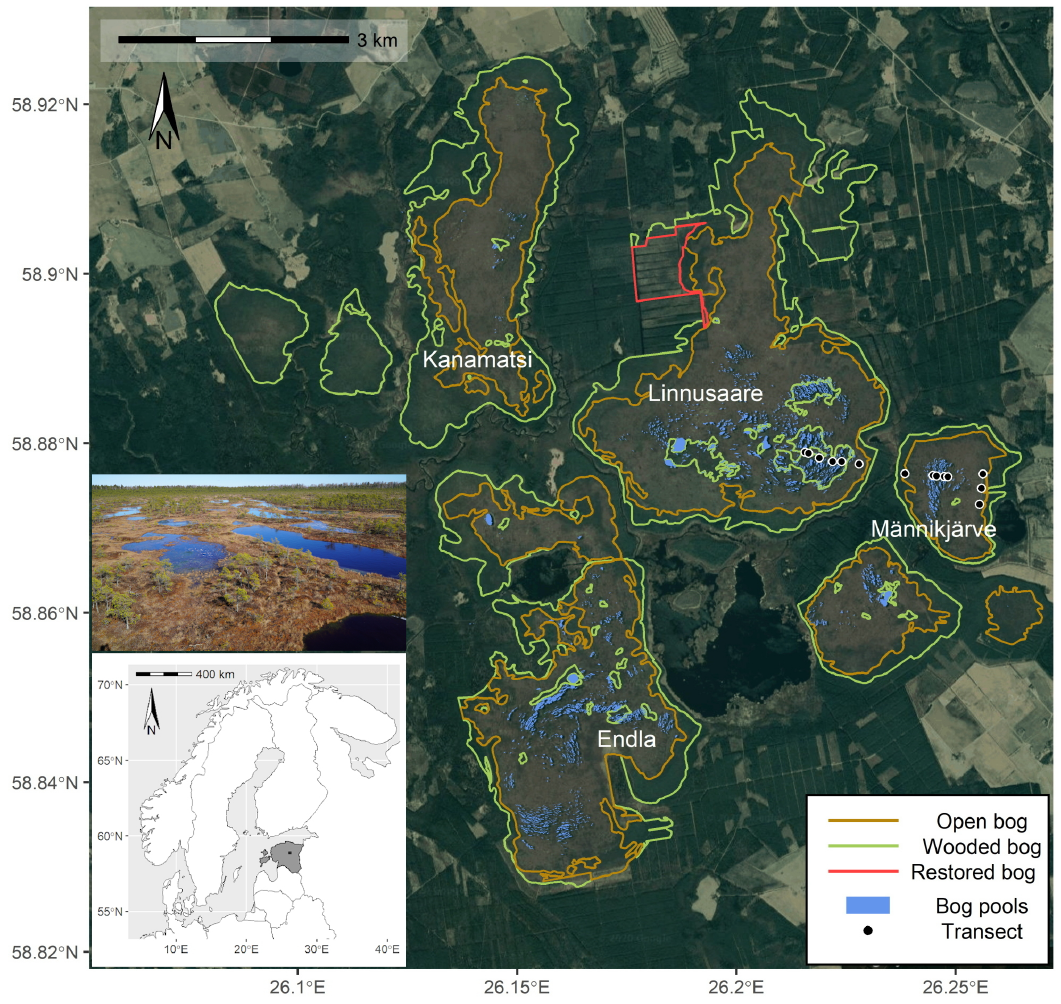
Figure 1. Main bog massifs in Endla mire complex with open and wooded bog area delineated. The hydrological monitoring transect of gauges and wells at Linnusaare and Männikjärve bogs are marked by black dots. Peatlands are defined as areas with peat depth >30 cm. The following land cover types are differentiated: open bog (tree height <1.3 m or canopy cover <0.3), wooded bog (tree height 1.3–10 m and canopy cover >0.3), restored bog and bog pools (area >100 m 2 ). Ridges-pool ecotope